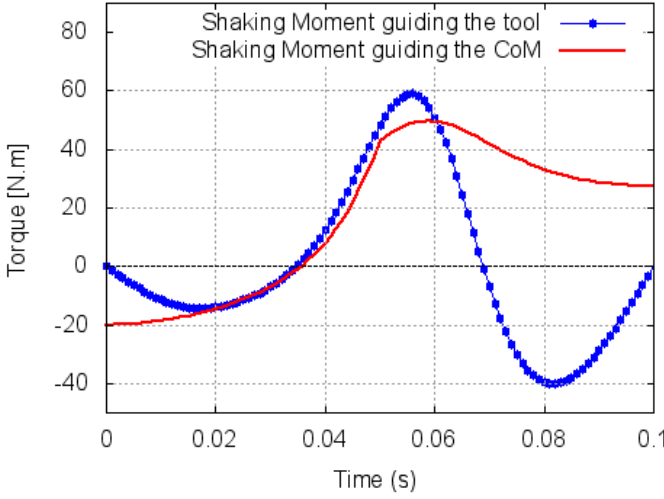
Figure 8. Shaking moment comparison: The blue curve is the shaking moment when the tool is guided with a cycloidal profile. The red curve is the shaking moment when the global CoM is guided with a “bang-bang”